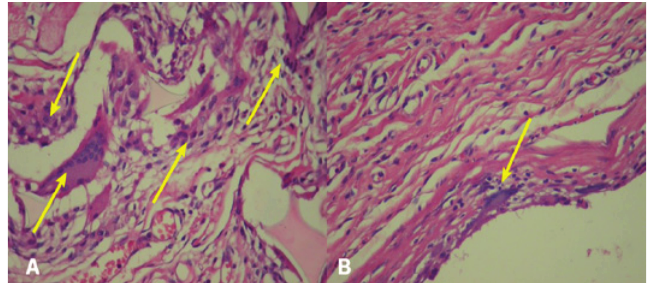
FIGURE 5 – Photomicrographs with strange body reaction. A . Intense in polyurethane foam. B . Discrete in silicone (200x). Note: In A , arrows indicate great amount of giant cells and in B only one cell giant.